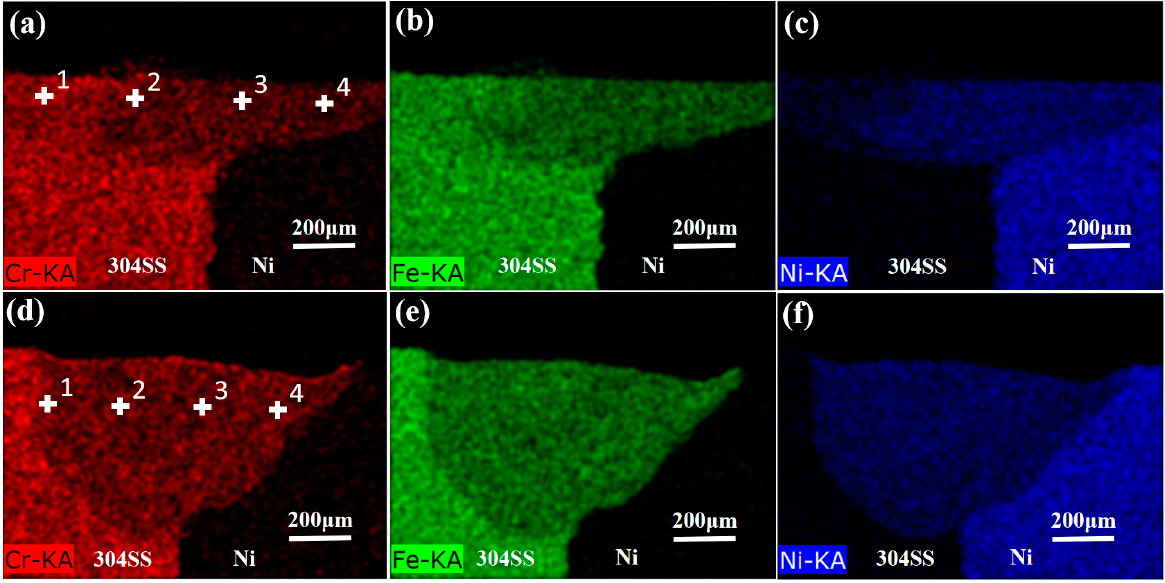
Figure 8. Distribution of major elements in the molten pool measured by EDS mapping. ( a – c ) Distribution of Cr, Fe, and Ni in pure argon and ( d – f ) distribution of Cr, Fe, and Ni in the AMO.